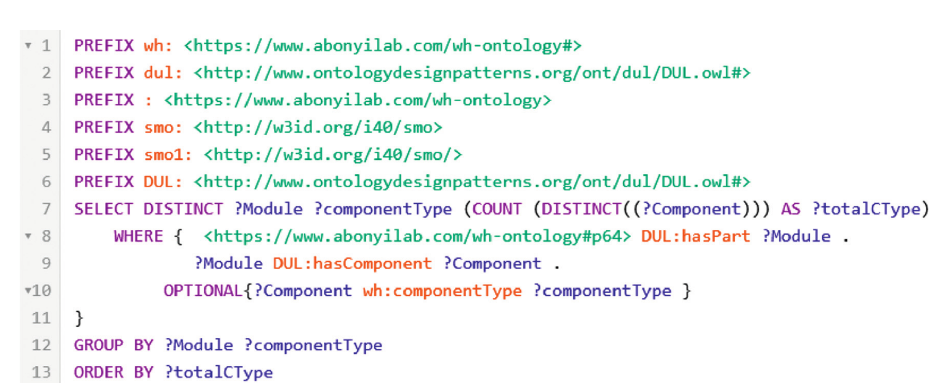
Figure 21: SPARQL query—module-component.